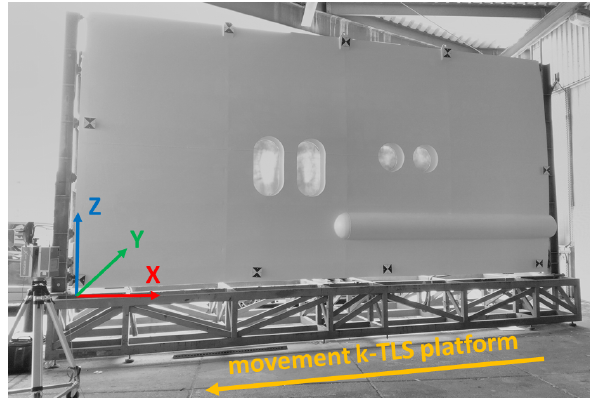
Figure 4. Test panel with reference points and origin of the local coordinate